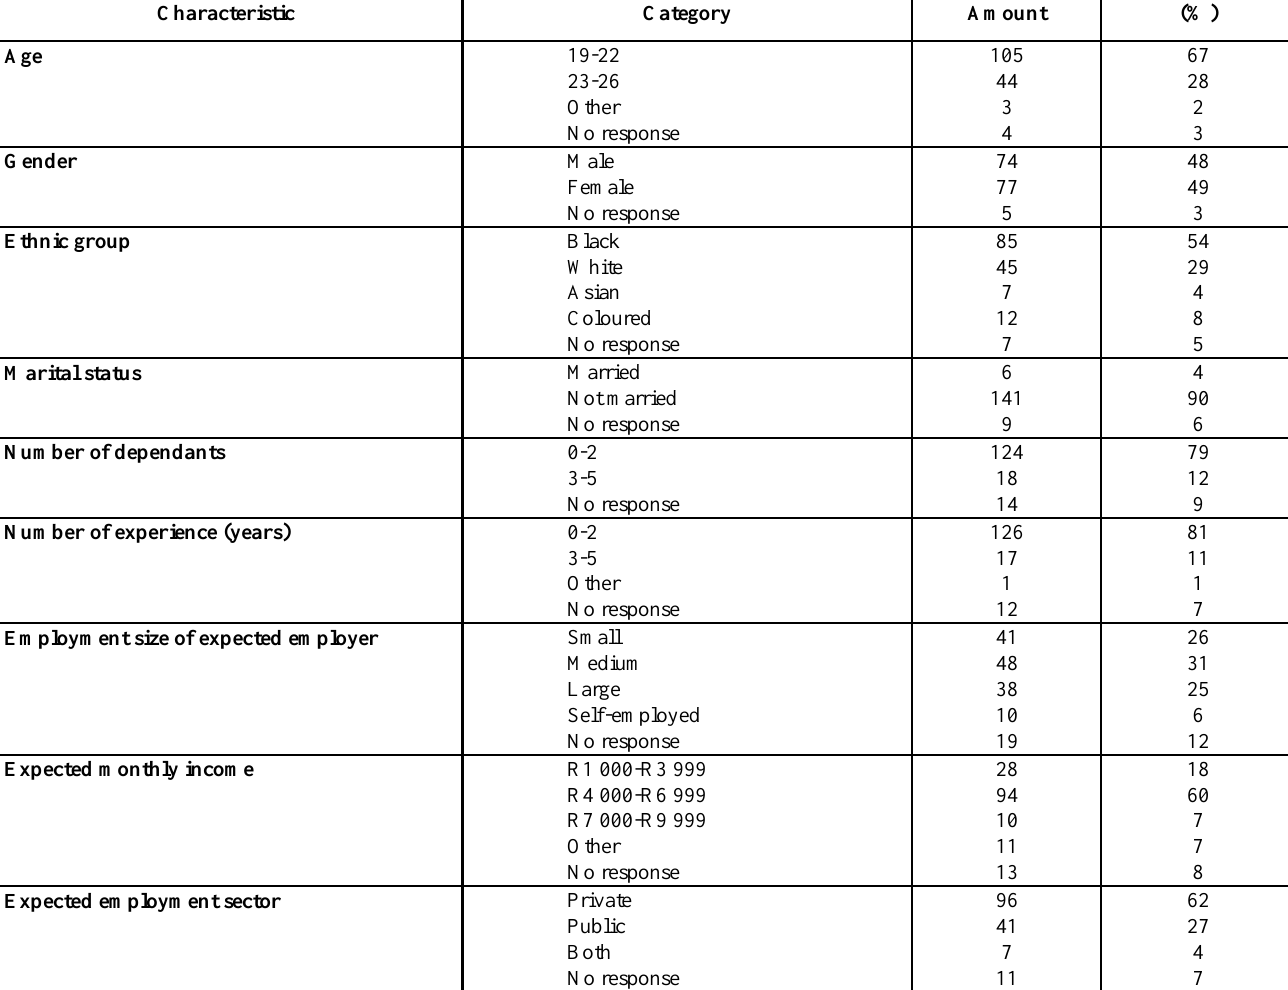
Table 1: Frequency distribution results: A graduate profile Characteristic